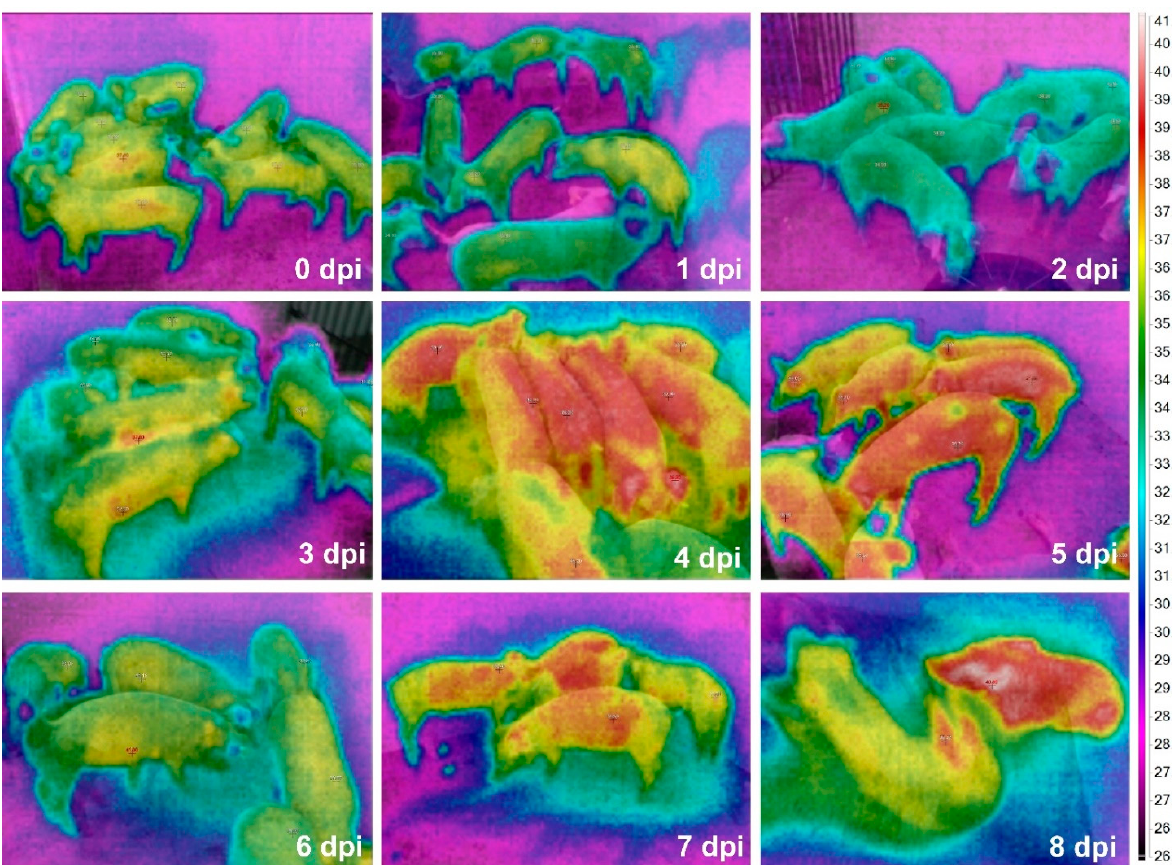
Figure 2. Time-serial thermal images of the pig herd including 50-day-old weaned pigs after ASF virus inoculation.